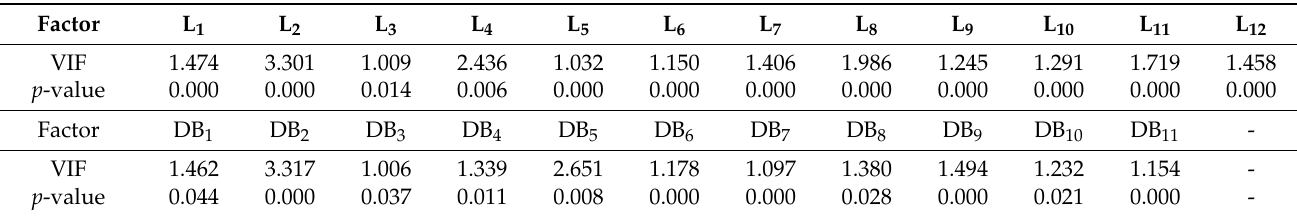
Table 3. VIF value of the conditioning